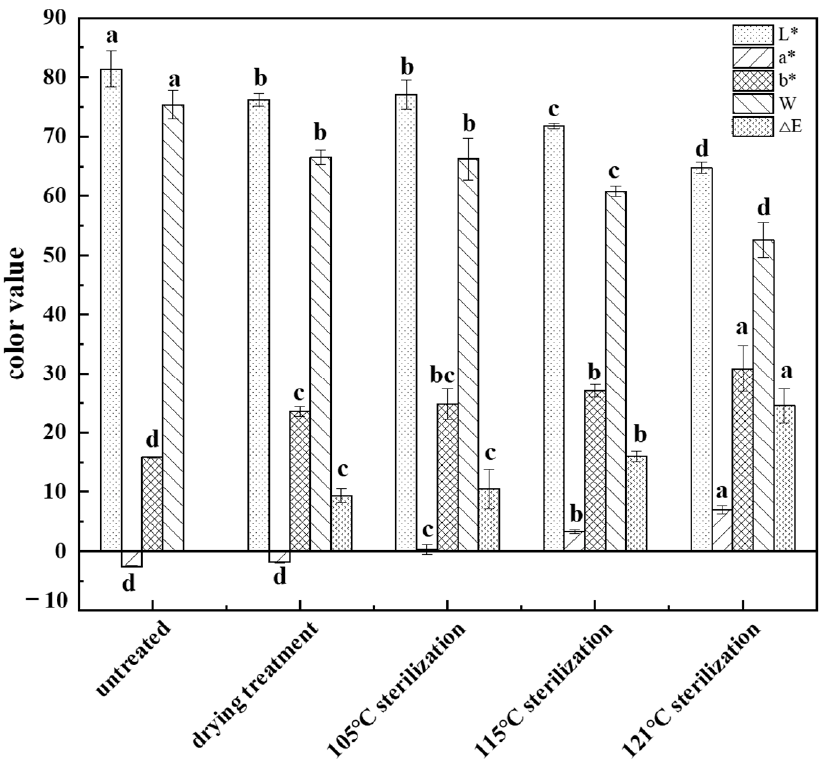
Figure 1. Influence of different treatments methods on the color of tilapia fish cake. The a, b, c and d represent significant differences among treatment groups, the same letter represents no significant difference between two treatment groups ( p > 0.05), and different letters represent significant differences between two treatment groups ( p < 0.05).